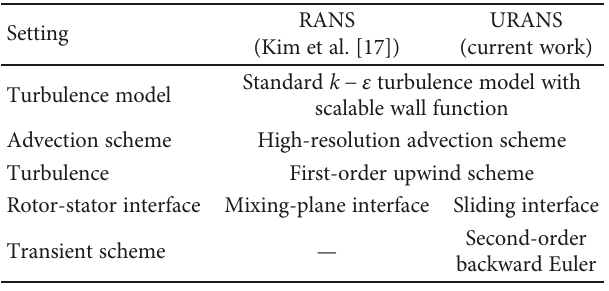
Table 2: Comparison of numerical setup between the RANS and URANS simulations.